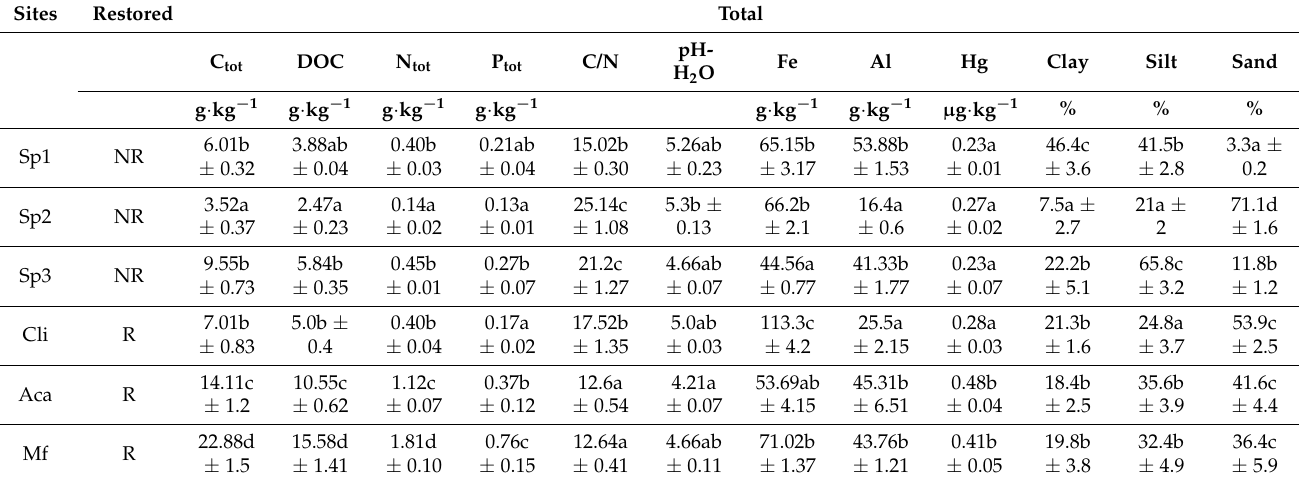
Table 1. Ctot, Ntot, Ptot: total C, N and P; DOC: total organic carbon; MBC: microbial biomass carbon; total Fe, Al, Hg: total iron, aluminum and mercury content. NR: non-restored sites, R: restored sites. Sp1, Sp2 and Sp3 are non-restored mining sites. Cli is a restored site with C. racemosa , Aca is a restored site with A. mangium, and Mf is a mixed fabaceous species ( n = 5, mean ± SD). For each parameter, values followed by different letters differ significantly with p < 0.05 with Tukey’s HSD test.